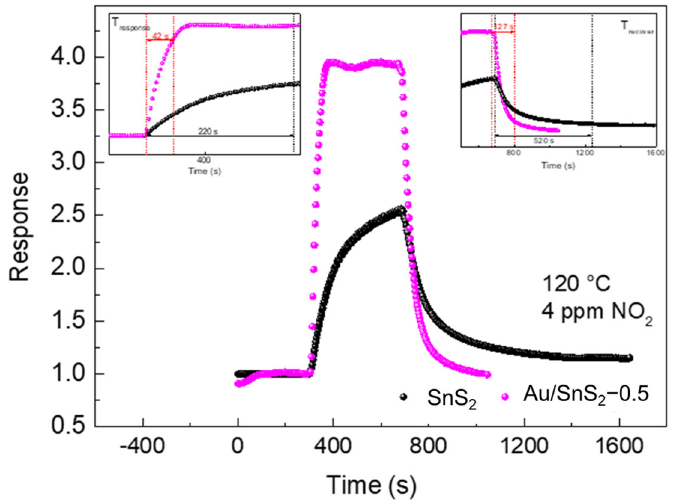
Figure 9. The response of SnS 2 and Au/SnS 2 -0.5-based sensors to 4 ppm NO 2 at 120 °C, and the inset images are the response/recover time of the samples.